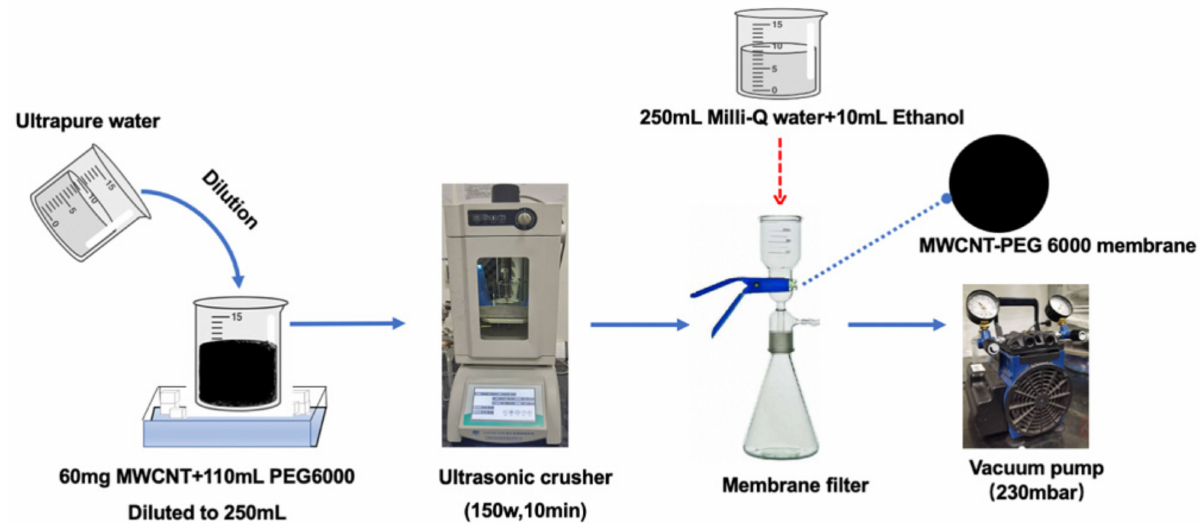
Figure 1. Schematic of preparing PEG non-covalent-functionalized MWCNT